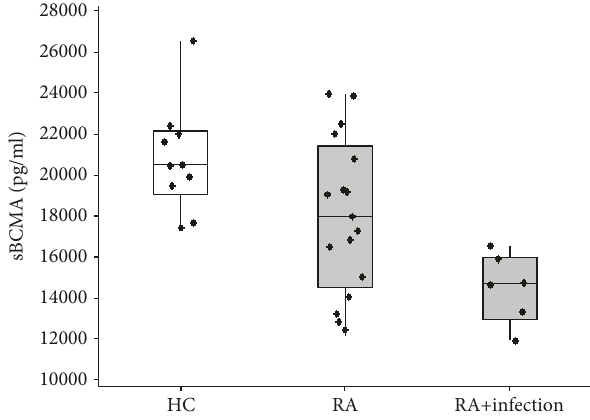
Figure 4: Box plots comparing serum sBCMA protein levels among RA patients with and without infections and healthy donors. Levels of sBCMA in healthy controls (HC, left white box; n = 10 ), RA patients without infections (middle gray box; n = 17 ), and RA patients with infections (right gray box; n = 6 ) are shown. Patients with RA with a history of infections had signi fi cantly lower sBCMA levels compared to RA subjects without a history of infections ( p < 0 05 ) and to healthy controls ( p < 0 01 ). ∗∗ p < 0 01 and ∗ p < 0 05